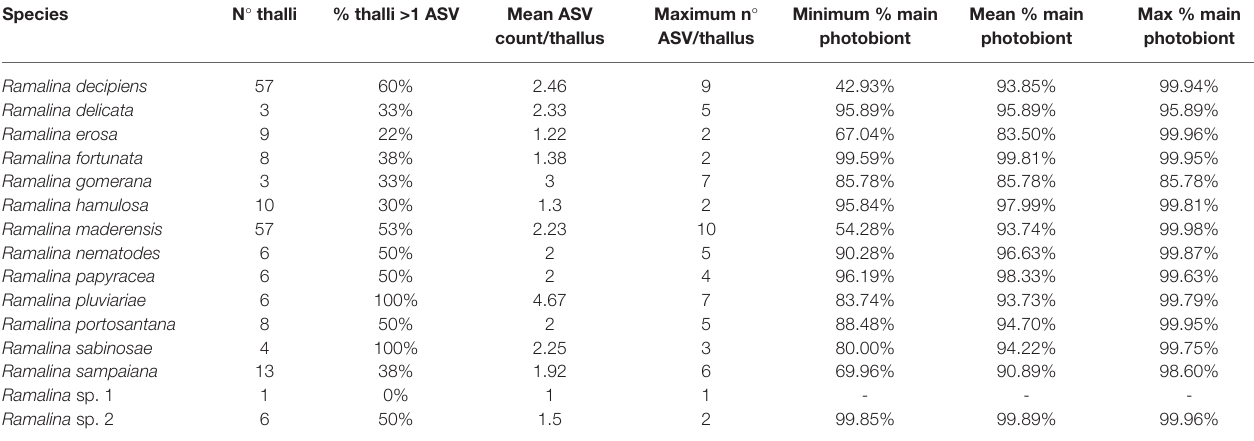
TABLE 2 | Summary of algal coexistence across Ramalina species. Species